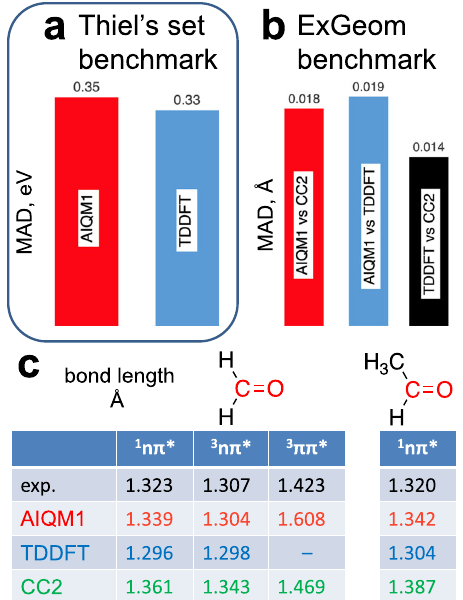
Fig. 9 Performance of the arti fi cial intelligence – quantum mechanical method 1 (AIQM1) for excited states. a Mean absolute error (MAD) in vertical excitation energies for Thiel ’ s benchmark set 66 (AIQM1 in red, time-dependent density functional theory, TDDFT, in blue). b MAD in bond lengths for the ExGeom benchmark set 26, 66 (AIQM1 vs approximate coupled cluster singles-and-doubles method (CC2) in red, AIQM1 vs. TDDFT in blue, TDDFT vs. CC2 in black). c Lengths of C – O bonds in formaldehyde and acetaldehyde as compared to experiment (experiment in black, AIQM1 in red, TDDFT in blue, CC2 in green; one value for TDDFT is missing due to the failed geometry optimization at this level 66 ). Values for TDDFT (B3LYP/TZVP), CC2, TDDFT vs. CC2, and experiment are taken from ref. 66